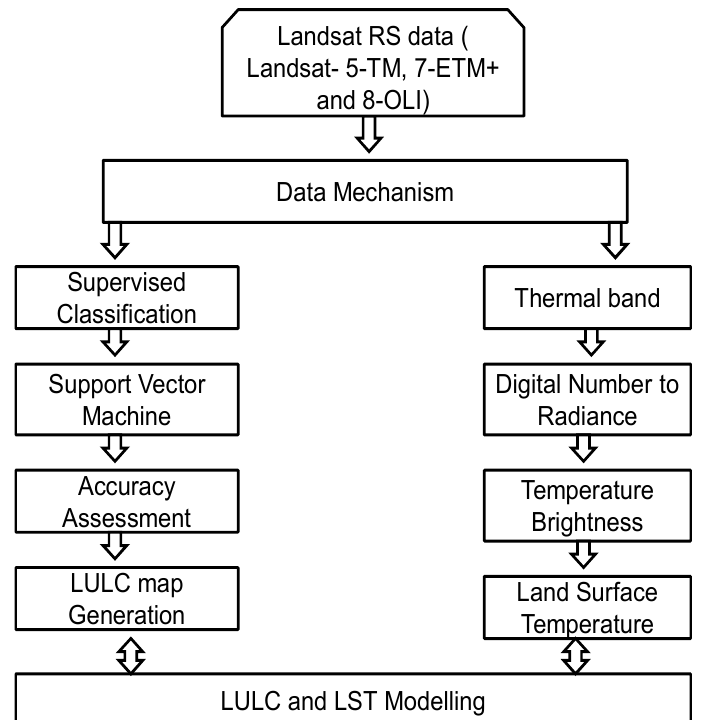
Figure 2. Flow chart for Land Use Land Cover and Land (LULC) and Land Surface Temperature (LST) methodology.